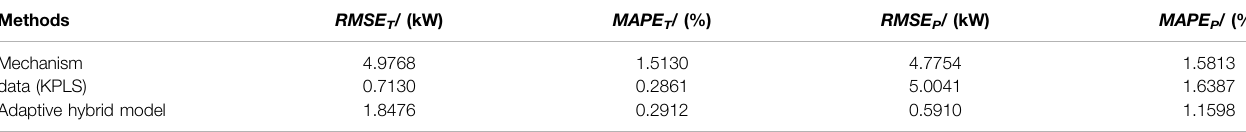
TABLE 3 | Calculation accuracy of different models under signal working condition (working condition 2). Methods